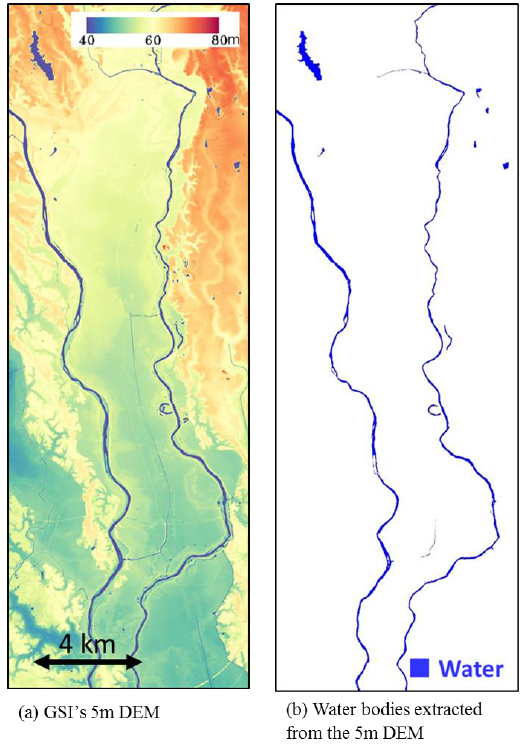
Figure 6. GSI’s 5-m DEM (a) used to extract original water